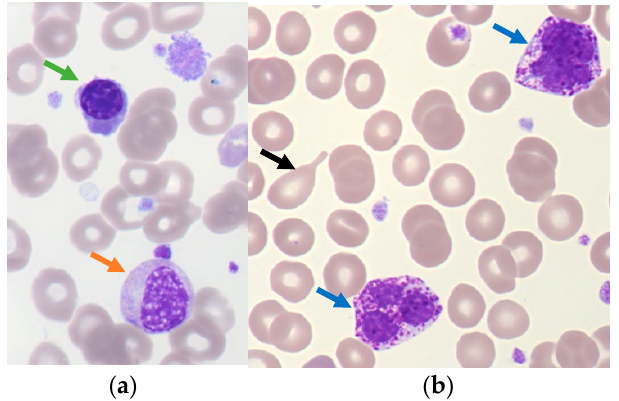
Figure 2. Indirect signs of myelo fi brosis on blood smear. ( a ) Leukoerythroblastosis with a polychromatophilic erythroblast cell (green arrow) and immature granulocytic cell (orange arrow); ( b ) Teardrop-shaped RBC (black arrow) and basophilic cell (blue arrow). (Optical microscopy, May Grünwald Giemsa, ×50 magni fi cation).